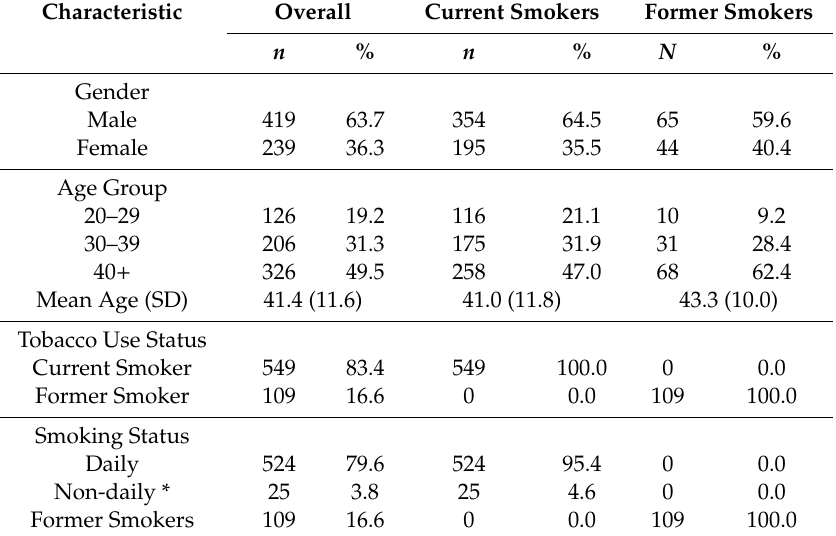
Table 2. Characteristics of current and former smokers using